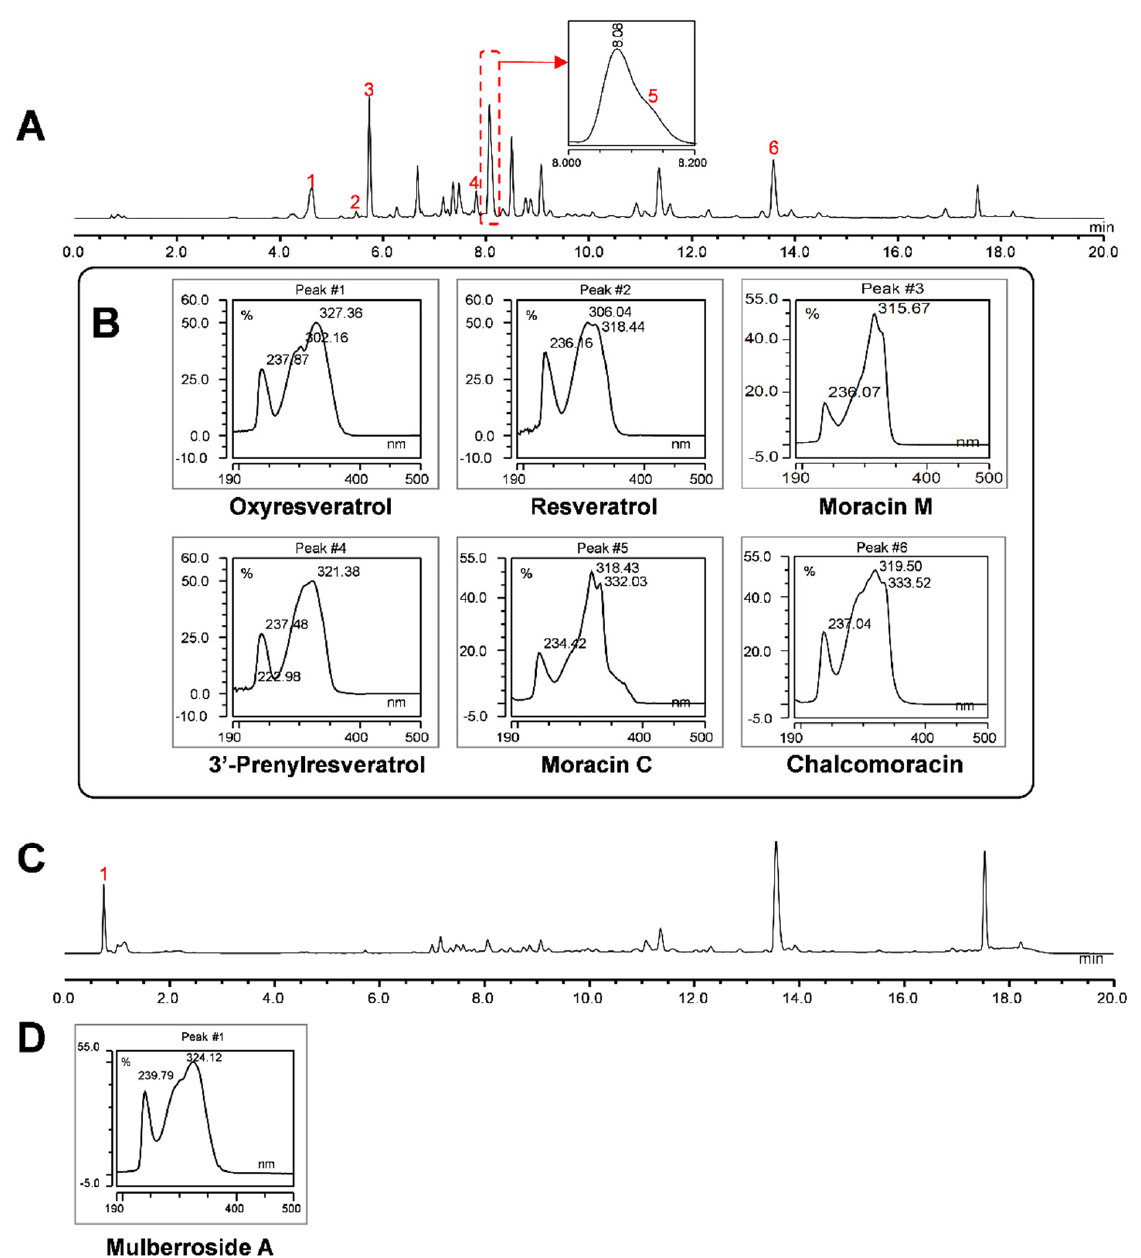
Figure 5. UV − spectra of compounds identified in white mulberry hairy root cultures. ( A ) HPLC chromatogram of hairy root line U − D2 medium extract after 48 h of elicitation with CD + MgCl 2 + H 2 O 2 (320 nm). Box shows close-up of peak from Rt 8 − 8.2 min. ( B ) UV − spectrum of the compounds identified in extracts of the culture medium (peaks 1 − 6 correspond to the red numbers shown in ( A )). ( C ) HPLC chromatogram of hairy root line U − D2 tissue extract after 48 h of elicitation with CD + MgCl 2 + H 2 O 2 (320 nm). ( D ) UV-spectrum of the identified compound in the root extract. The highest yield of oxyresveratrol was 6.27 ± 1.24 mg/g DW (equivalent to 8.67 mg/L